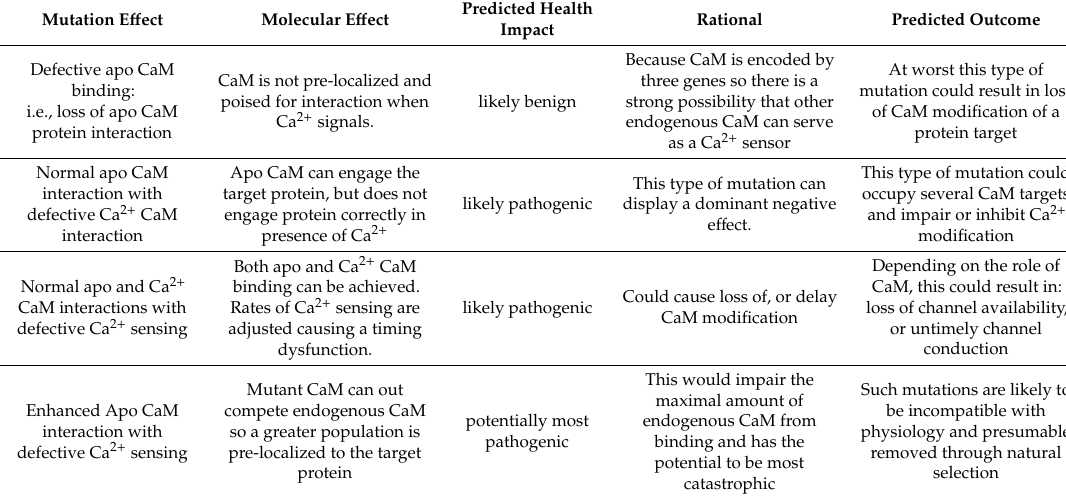
Table 2. Potential Mechanisms of CaM